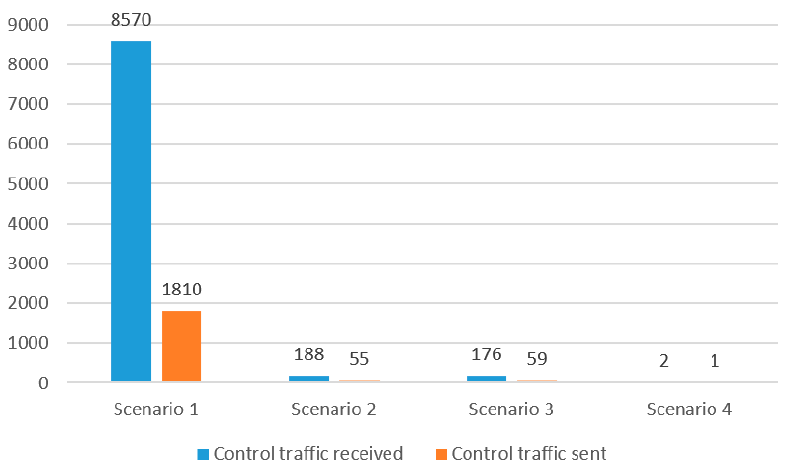
Figure 10. Comparison of control traffic values across all four study scenarios.